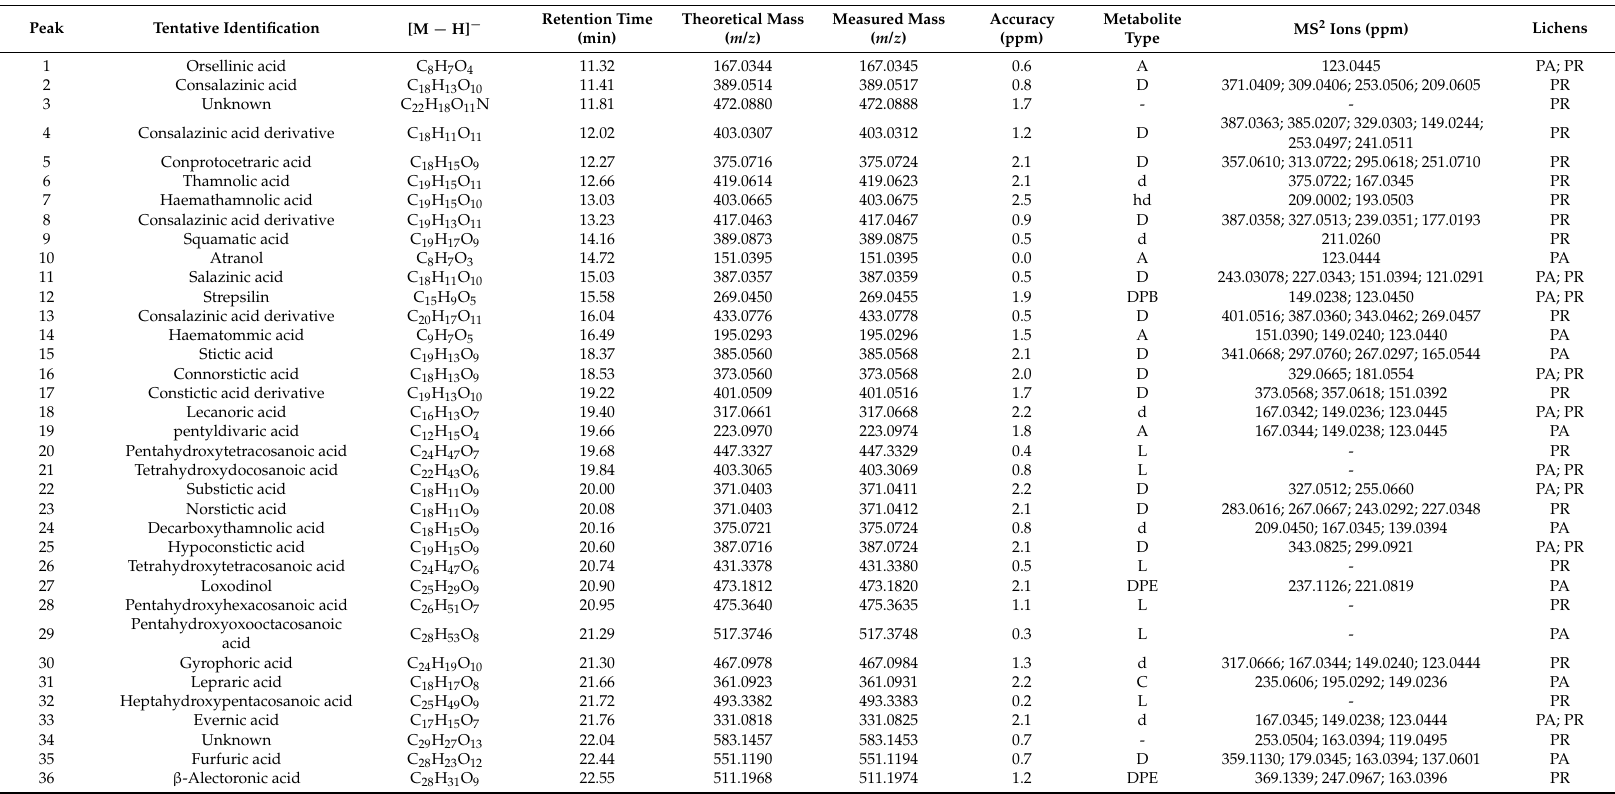
Table 1. Identification of lichen substances in Parmotrema species by